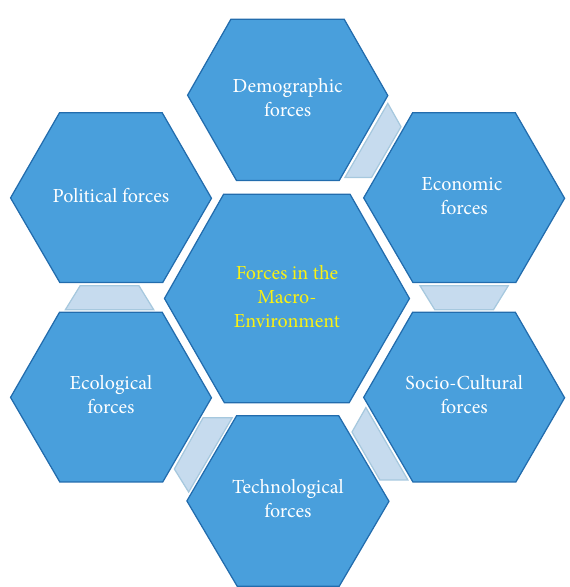
Figure 2: The impact of macrofactors on place